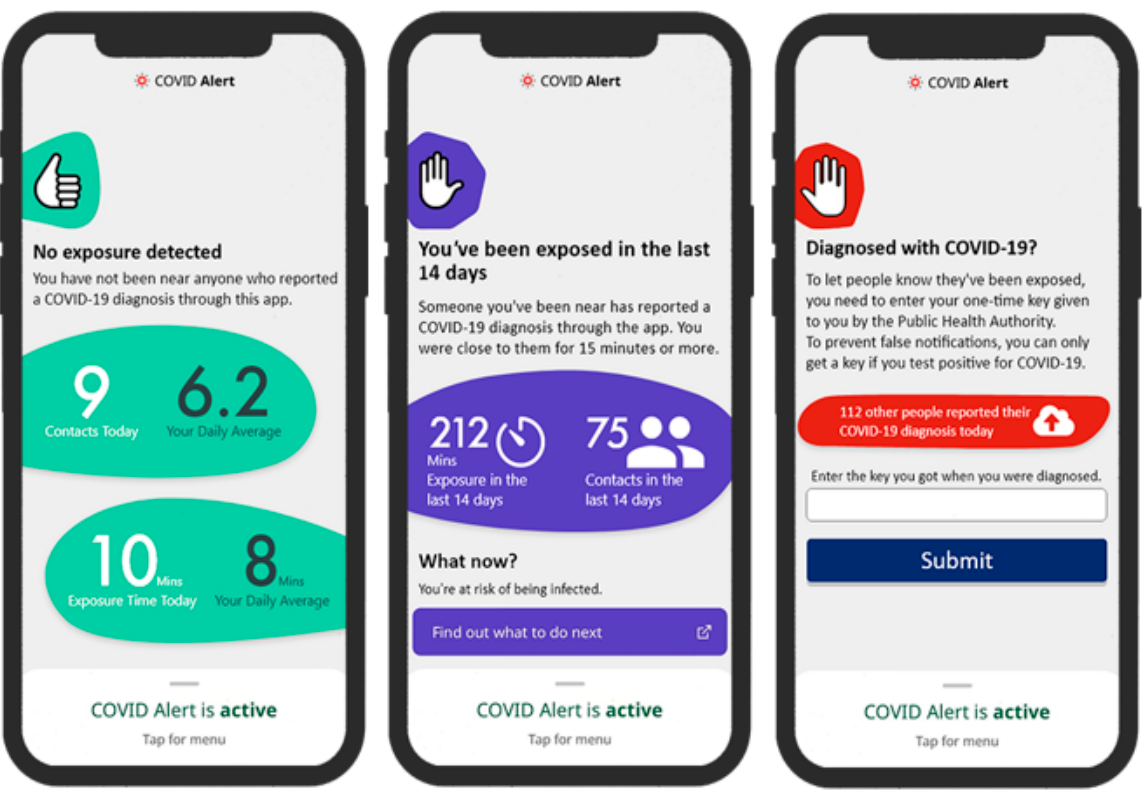
Figure 1. Persuasive versions showing the incorporation of self-monitoring (first, second) and social learning (third) [18].